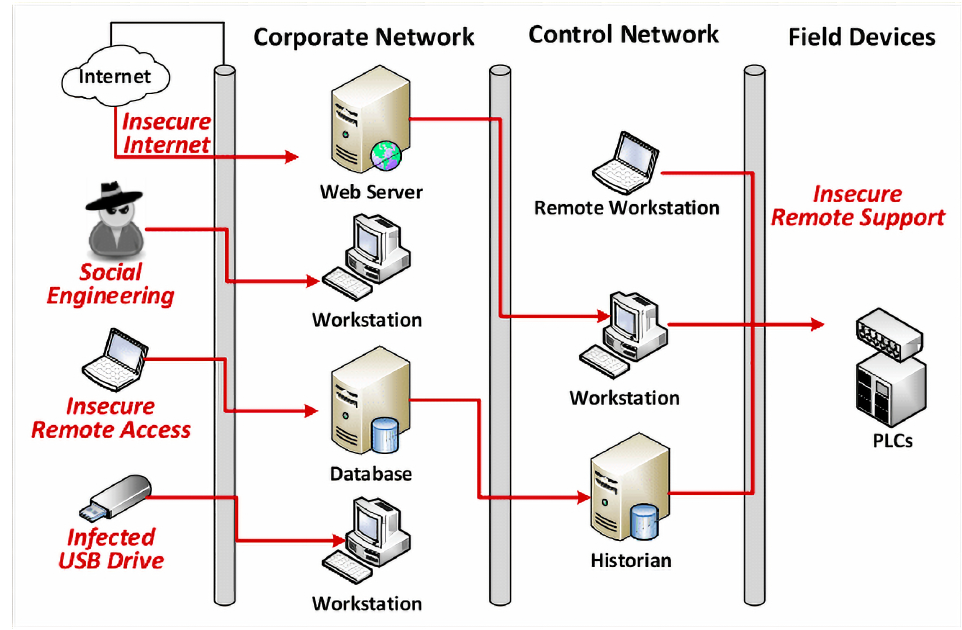
Figure 4. APT attack scenario